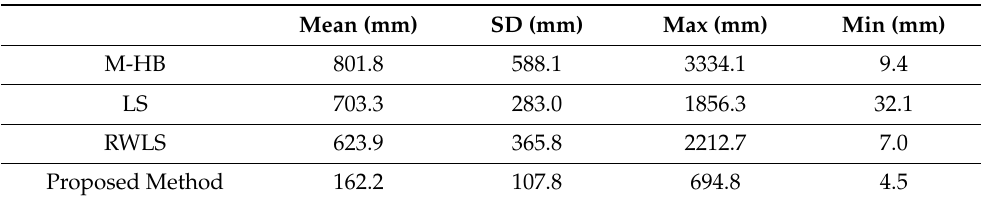
Table 4. Comparison of estimation error between the proposed method and previous methods for the square path.